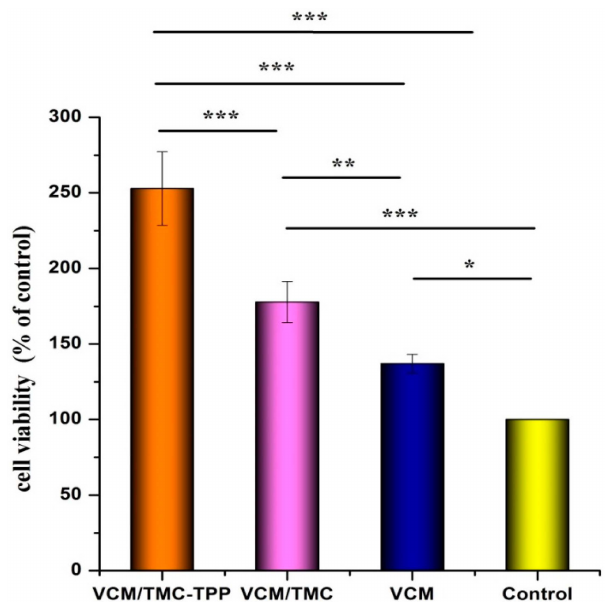
Figure 11. MTT (3-(4,5-dimethylthiazol-2-yl)-2,5-diphenyltetrazolium bromide) assay for cell proliferation activity in vitro . *** , p < 0.001; ** , p < 0.01; and * , p < 0.05.